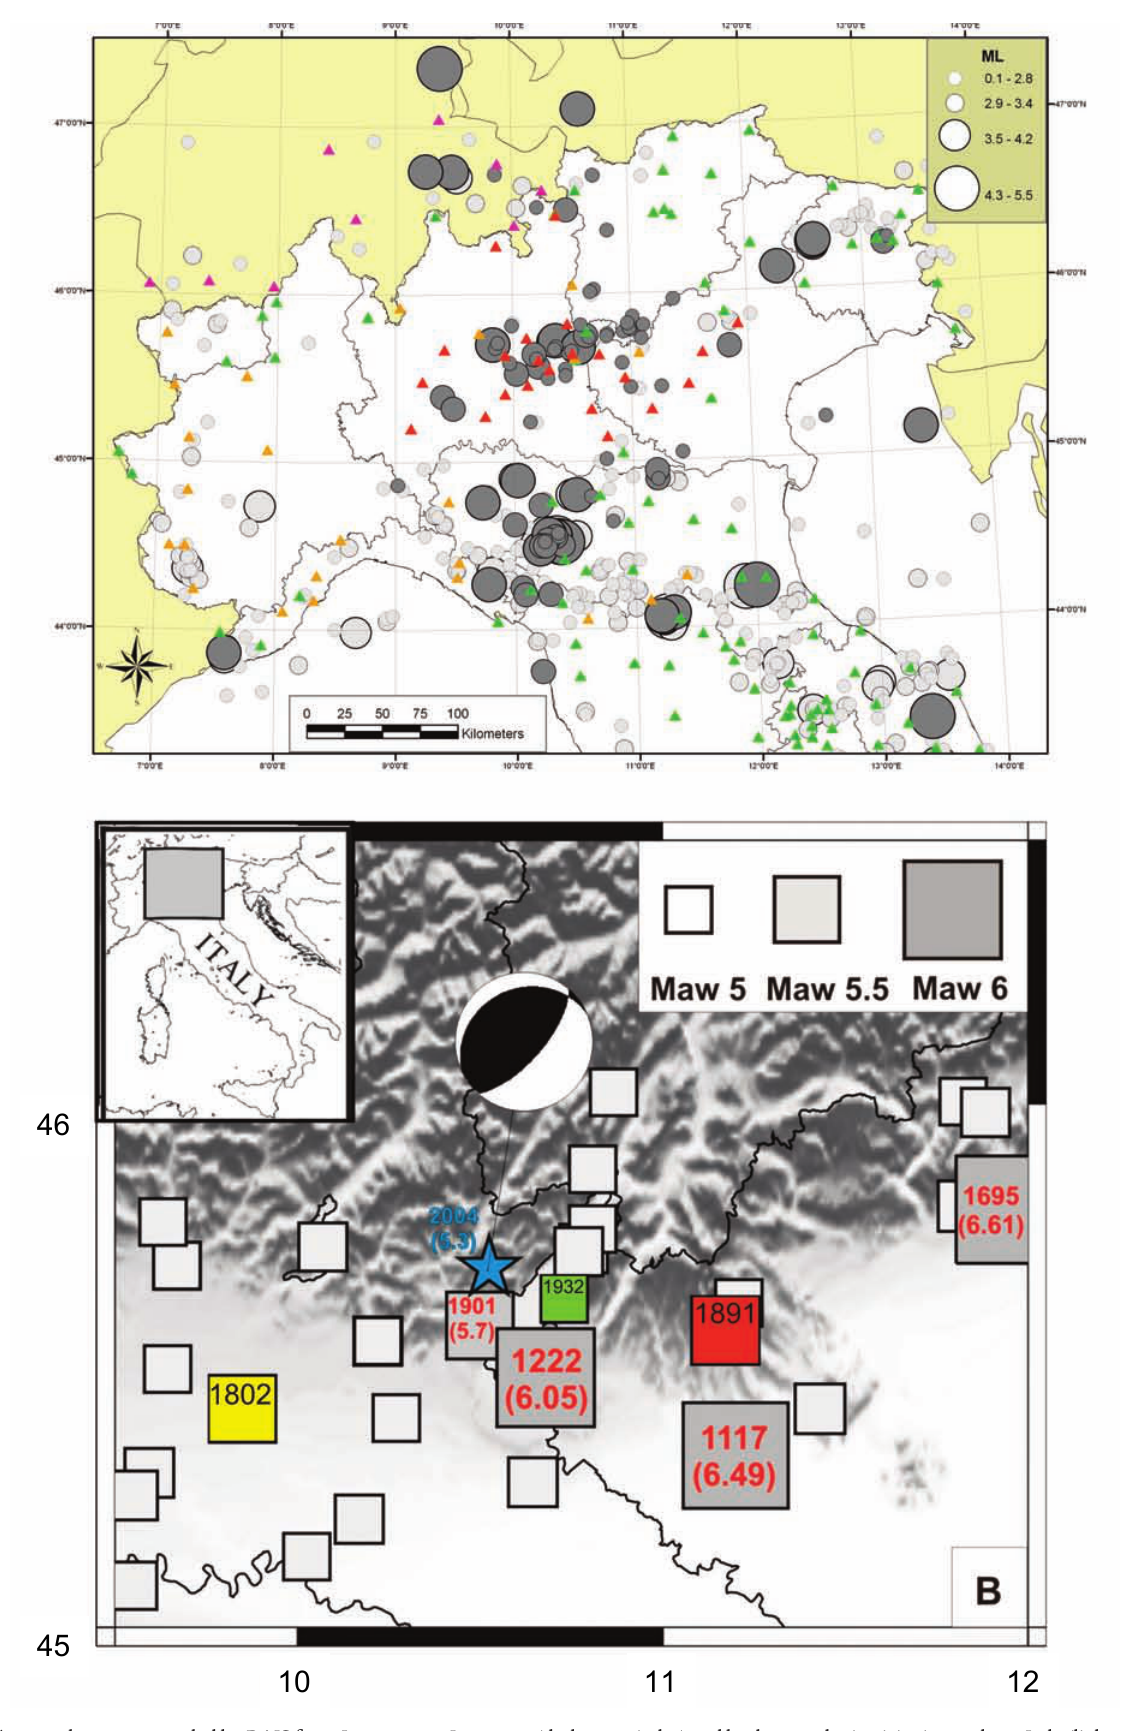
Figure 2. Top panel: events recorded by RAIS from June 2006 to June 2010 (dark grey circles) and background seismicity in northern Italy (light grey circles). Epicenter coordinates are derived from the official INGV instrumental bulletin (http://bollettinosismico.rm.ingv.it/). Red triangles, RAIS strong-motion stations. Bottom panel: historical seismicity of the area under study (from CPTI04) [Gruppo di Lavoro CPTI 2004]. Blue star, epicenter of the November 5.2, Salò 24, 2004, M L